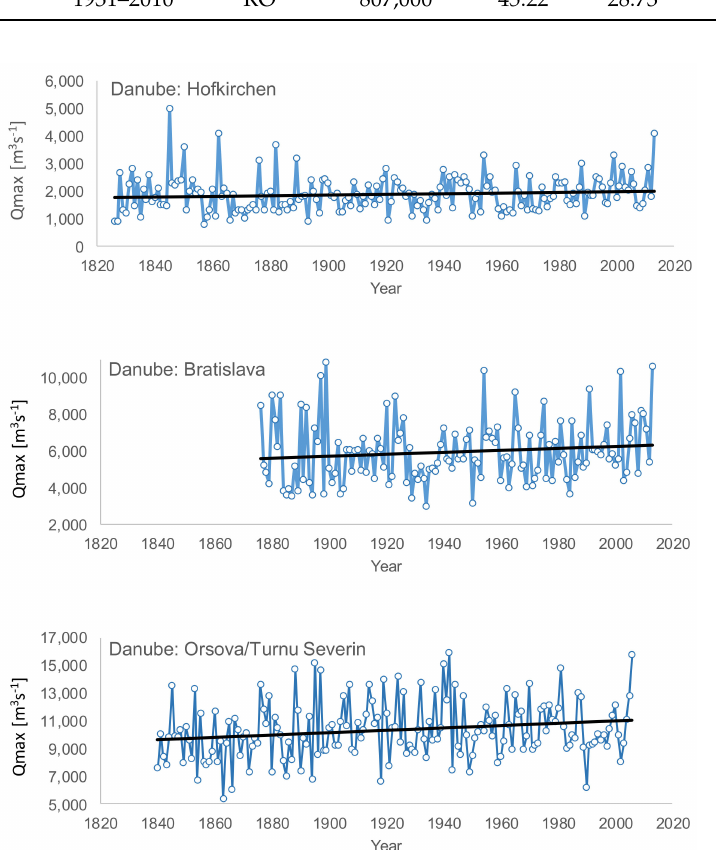
Figure 2. The maximum annual discharge series for selected gauging stations located in the upper, middle and lower Danube (with long data